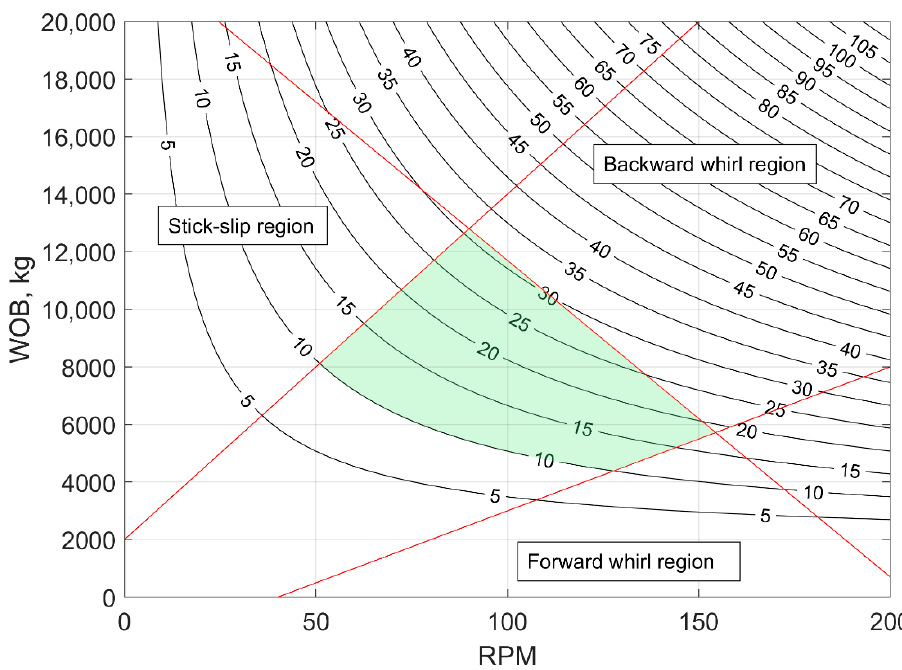
Figure 2. Contour map of dysfunction-free ROP (m/h) as a function of WOB and RPM in formation A , with generic critical values of WOB and RPM which mark the onset of vibrational foundering effects when drilling in this formation.